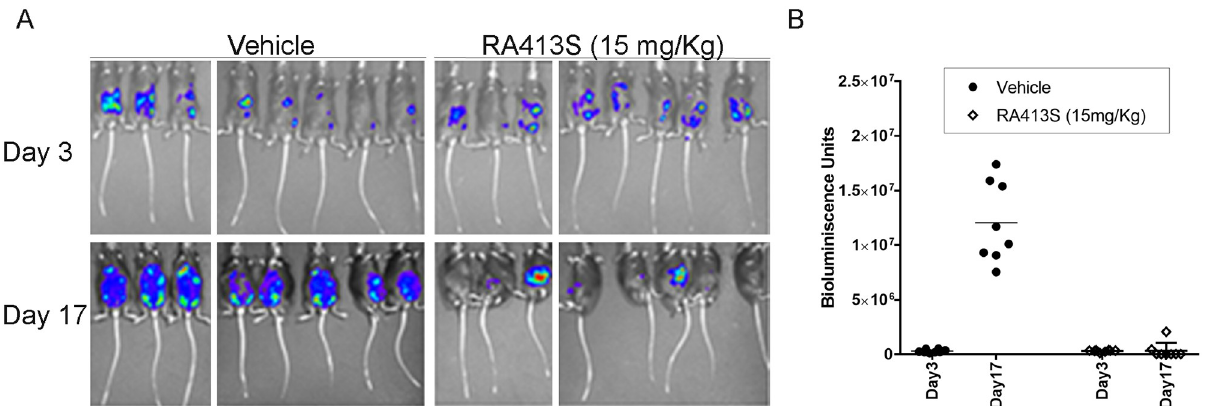
Fig 8. Tumor growth inhibition by RA413S in a syngeneic mouse model of ovarian cancer. (A) C57BL/6 mice administered ID8-Vegf+ Defb29+ syngeneic mouse model of ovarian cancer expressing luciferase [20] intraperitoneally were imaged for randomization by tumor burden before treatment (at day 3 post tumor inoculation, n = 16). Treatment was initiated on day 3 unblinded and the mice were imaged again after treatment with either vehicle (25% β -hydroxypropylcyclodextrin) or RA413S (15mg/Kg/every 3 days/total 5 doses) in 8 mice per each group on day 17 using IVIS200 to quantify the bioluminescence expressed by the tumor cells. Bioluminescence at days 3 and 17 is presented for all mice (B). A significant difference in bioluminescence was observed p < 0.0001.